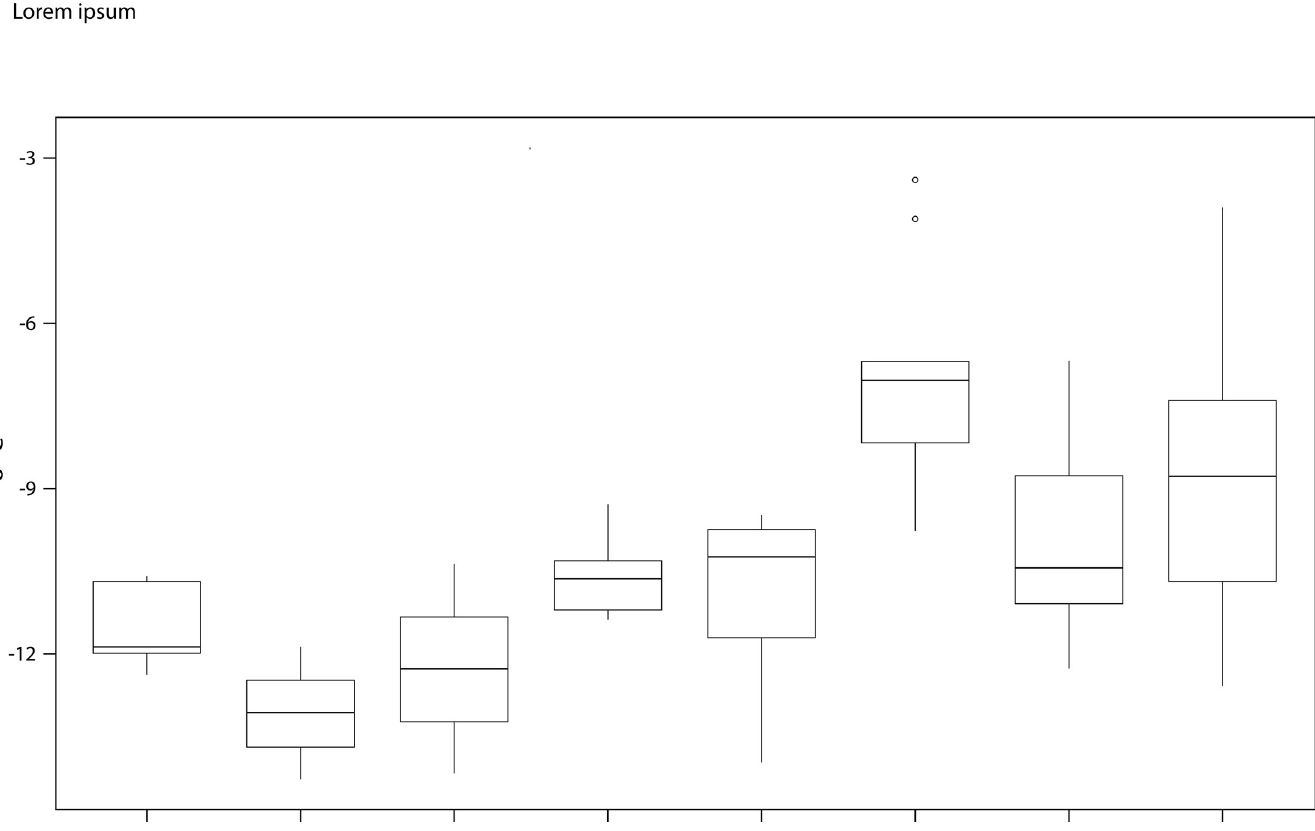
Fig 5. Boxplots of stable carbon isotope ratios for Iron Age/Scythian era individuals across Ukraine separated by site. Site codes: Vinogradnoe (VI), Peshtchanka (PE), Kirovograd (KI), Shakhta Stepnaya (SH), Nevskoe (NE), Alexandropol (AL), Babina Mogila (BM), Drana Kokhta (DK), Ordzhonikidze (OR), Zolotaya Balka (ZB), Medvin (ME), Mamai-Gora (MG) and Bel’sk